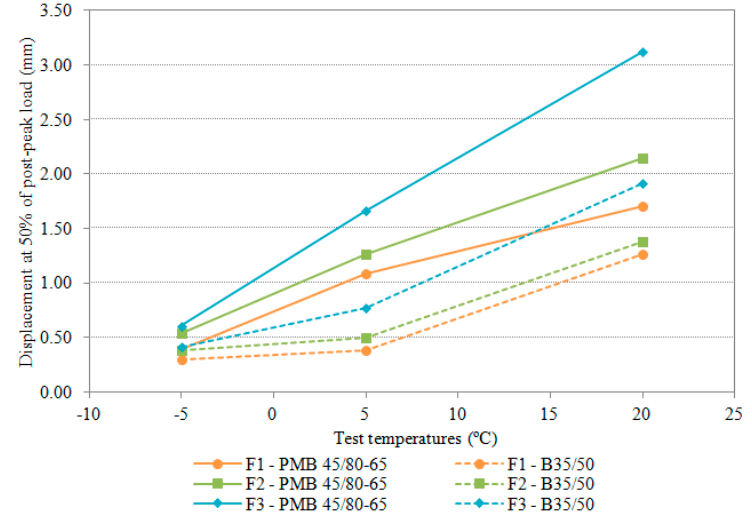
Figure 7. Displacement at 50% of post-peak load versus temperature.